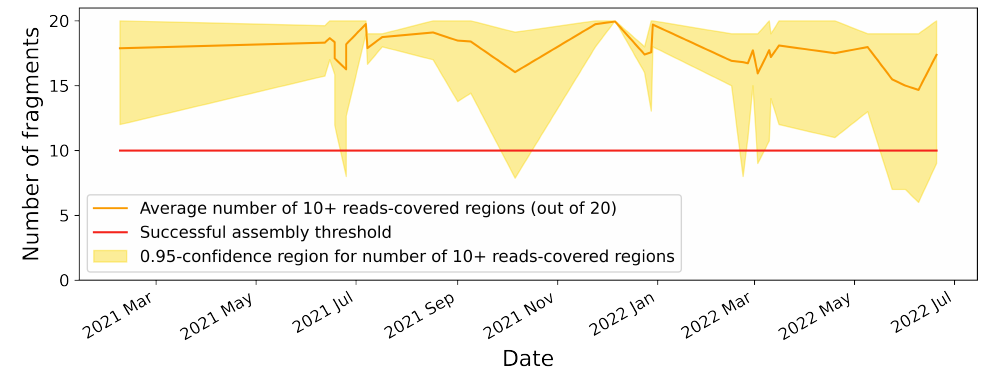
Figure 1. Timeline of coverage quality for S-protein gene sequencing from March of 2021 to July of 2022. The orange line represents the average number of 10+ read-covered regions (out of 20) in a single run. Yellow region shows 95%-confidence region for runs (2.5% of the best and worst results are discarded). The red line demonstrates the level of 10 regions covered by at least 10 reads, which is already a sample sequencing